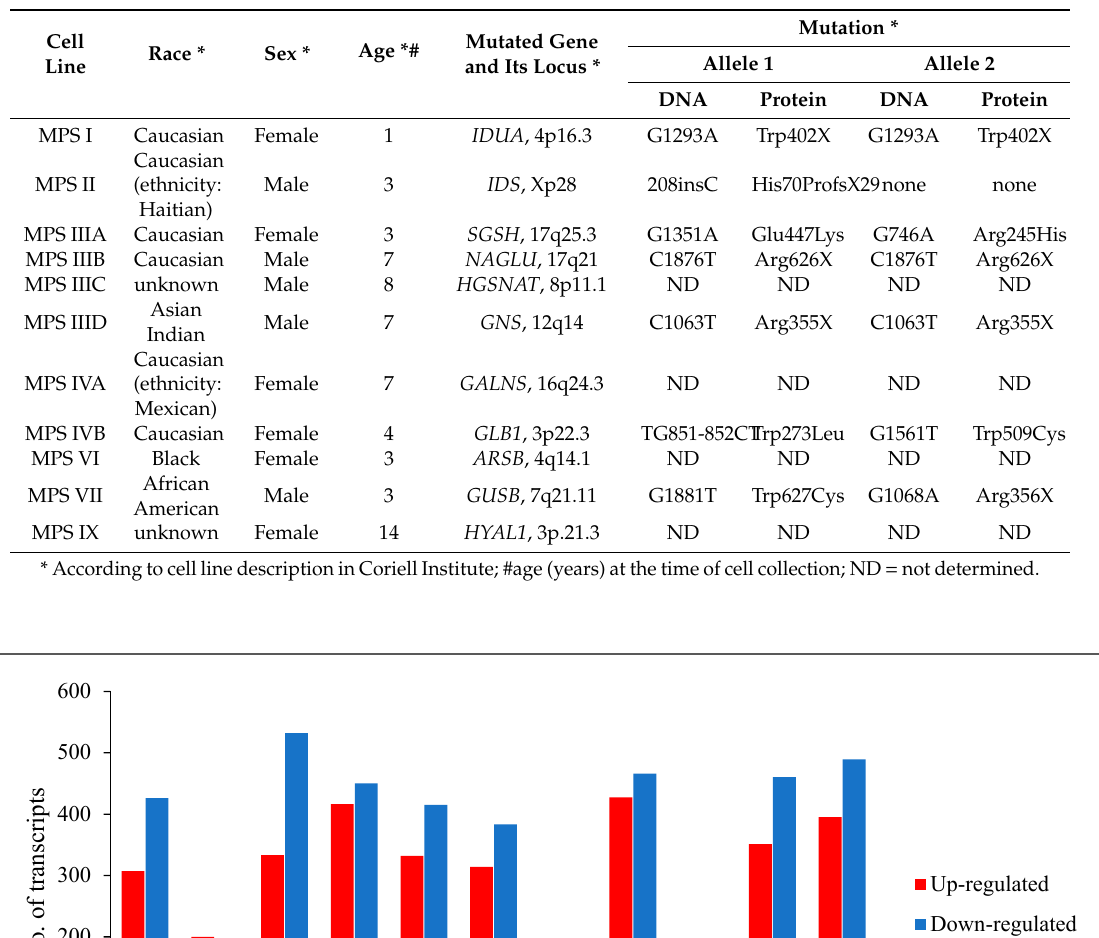
Table 2. Characteristics of MPS patients’ derived fibroblast used in this study.